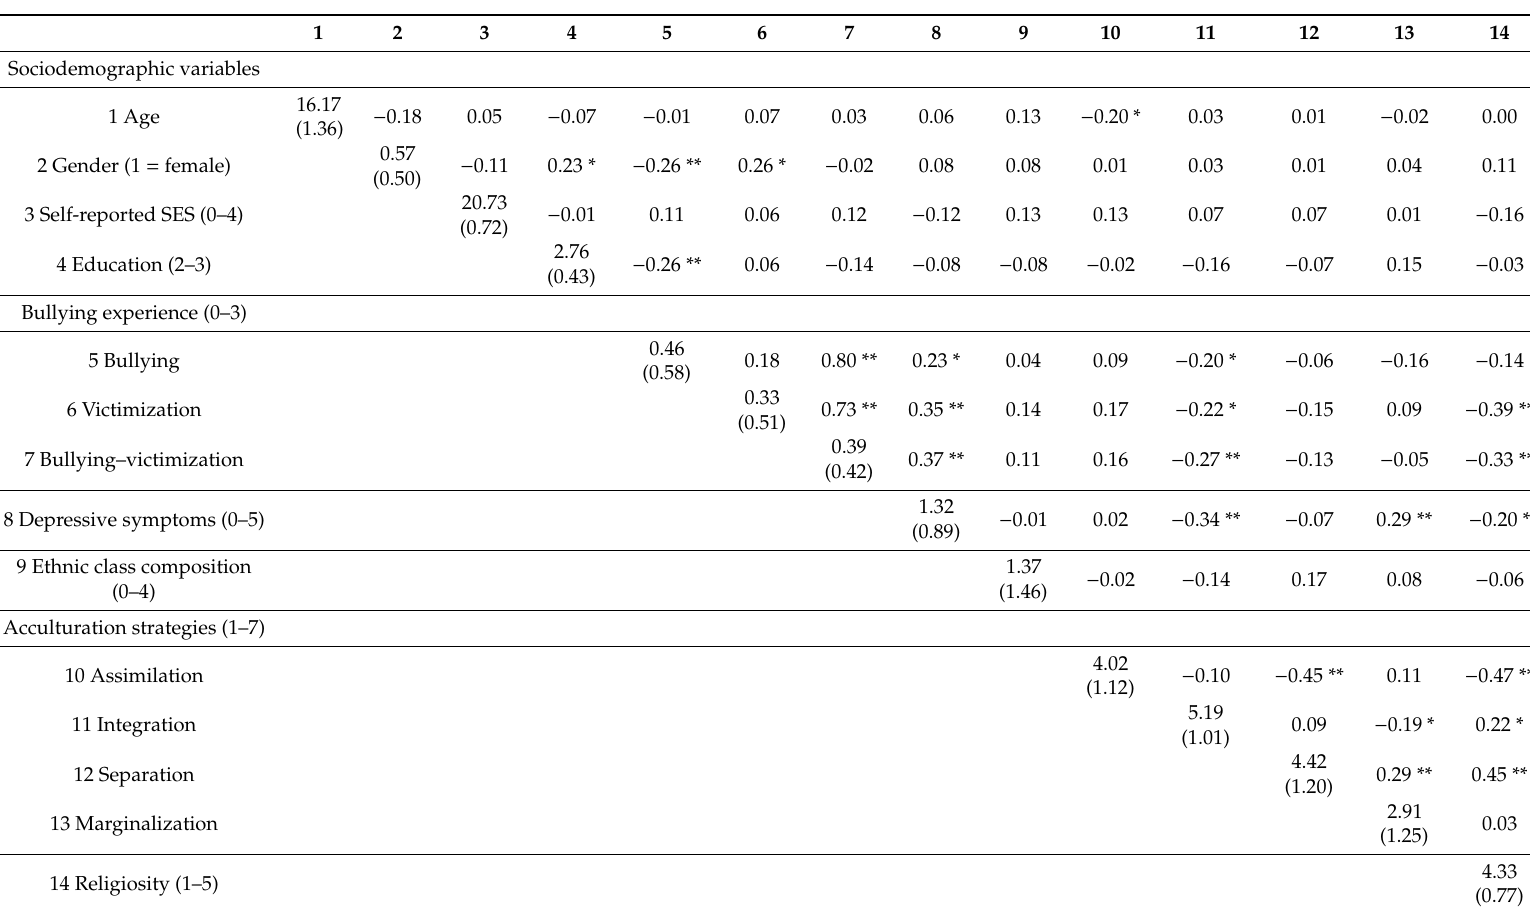
Table 1. Correlations between the included variables with means and standard deviations in brackets of the respective variable in the